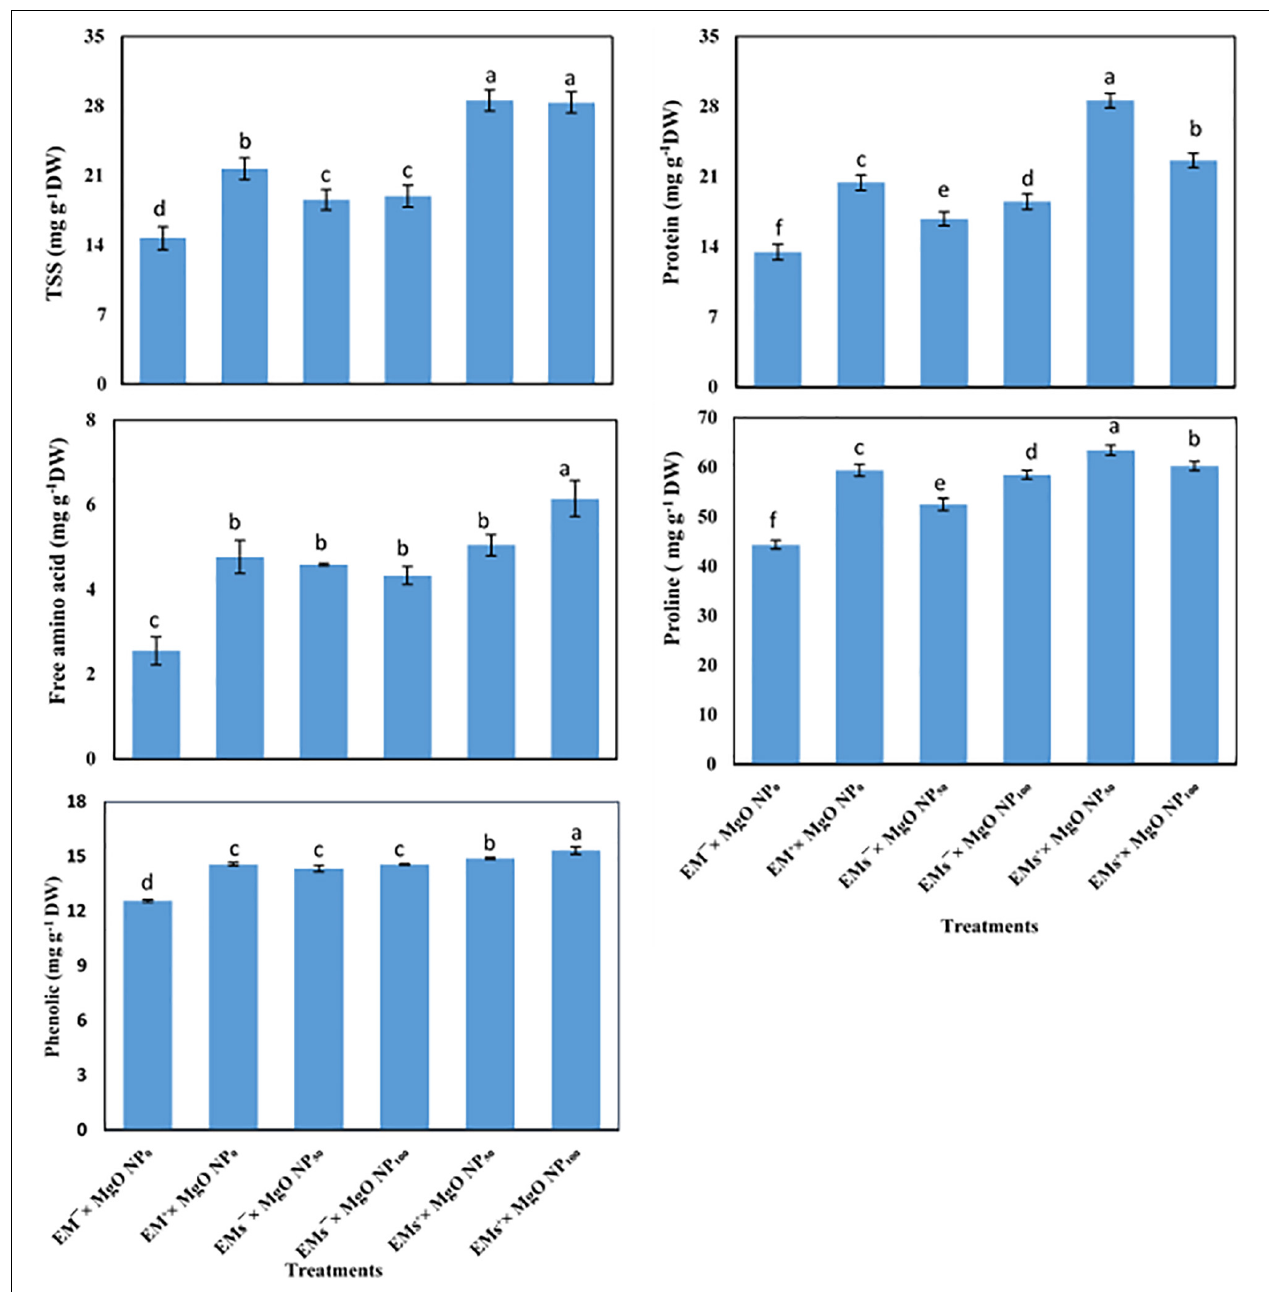
FIGURE 1 | Interactive effect of effective microorganisms (EMs) interacted with foliar application with magnesium oxide (MgO) nanoparticles (MgO-NP) on total soluble sugars (TSS), proteins, free amino acids, proline, and phenolics of sweet potato ( Ipomoea batatas L.) as average for both seasons. Different letters on the bars refer to significant differences among means based on Fisher’s least significant difference test at the p < 0.05